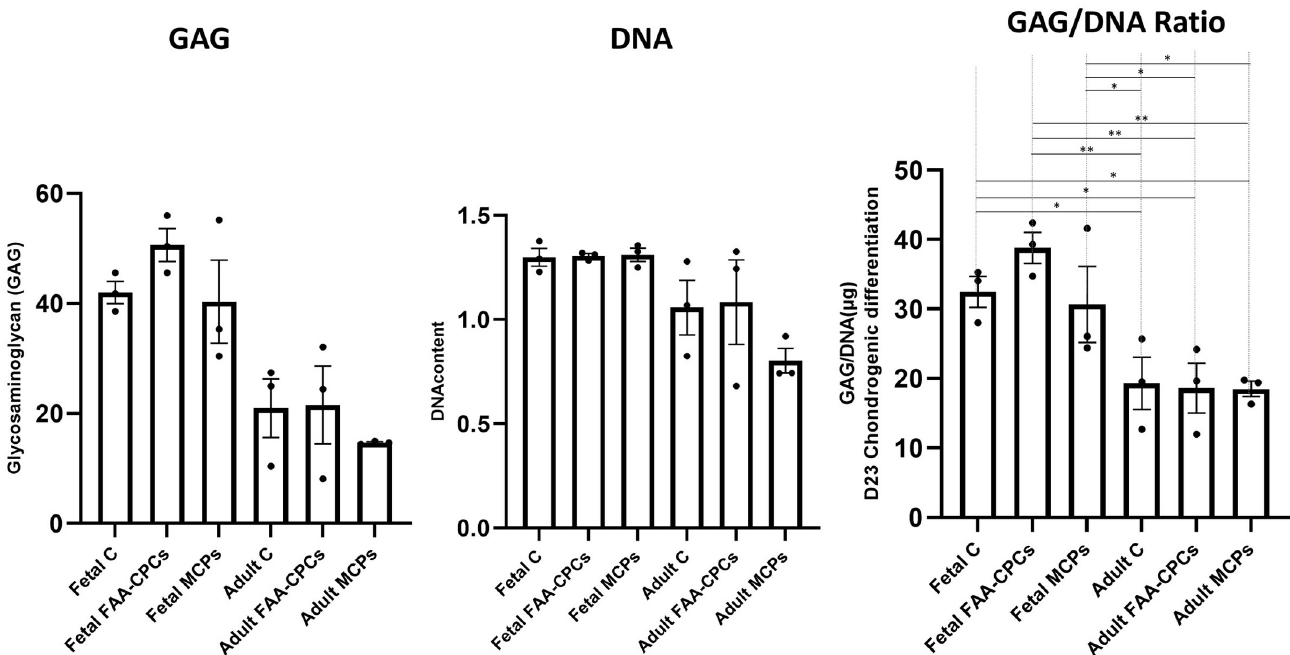
Fig 8. Measurement of the total GAG, DNA and GAG/DNA content of differentiated chondrogenic pellets. Fetal Chondrocytes, FAA-CPCs and MCPs demonstrated significantly higher levels of GAG/DNA when compared to their adult counterparts. All values are expressed as Mean ± standard error mean ( * P < 0.05, ** P < 0.01, *** P < 0.001), from three biological samples (n =